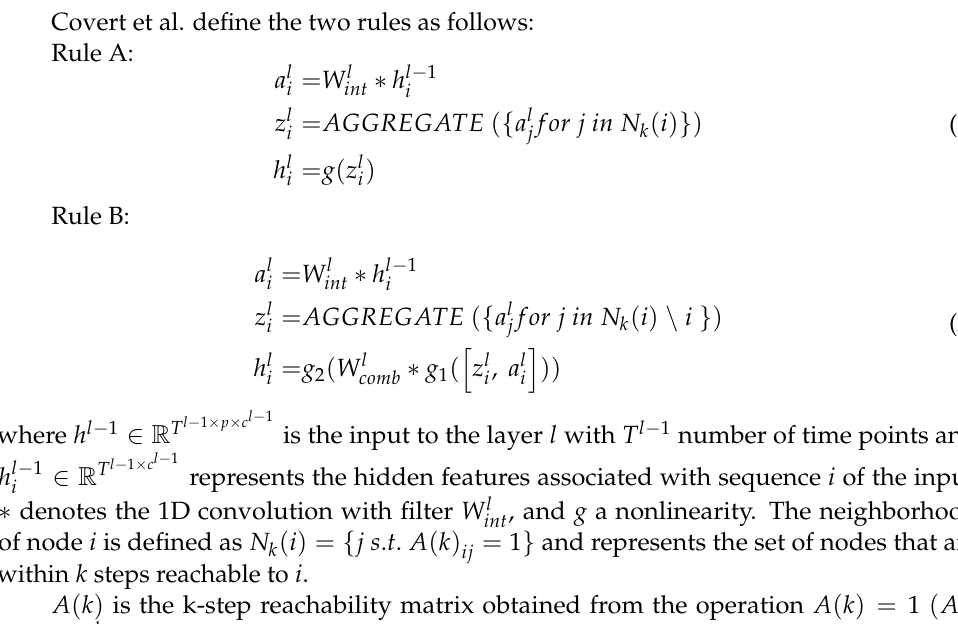
Figure 1. Different aggregation rules of the STC layer. Both rules begin by applying a 1D convolution along the temporal dimension and then: ( a ) Rule A aggregates features from the node’s neighborhood including the node itself, and ( b ) Rule B aggregates features from the node’s neighbors, and then combines these features with the node’s own features.